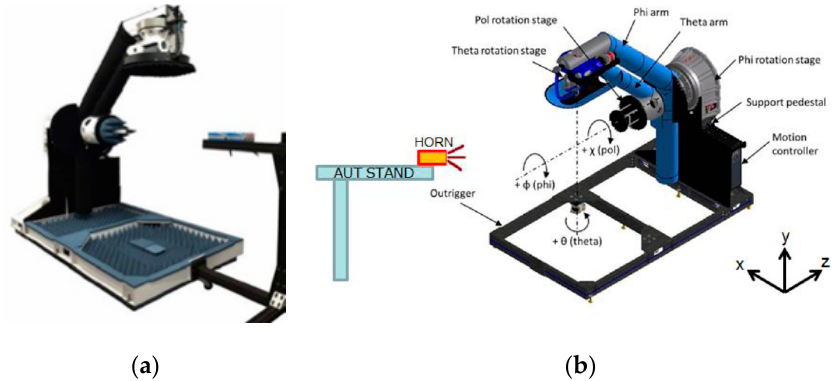
Figure 16. NSI-700S-360 antenna chamber, ( a ) instrument diagram; ( b ) equipment setup [26].